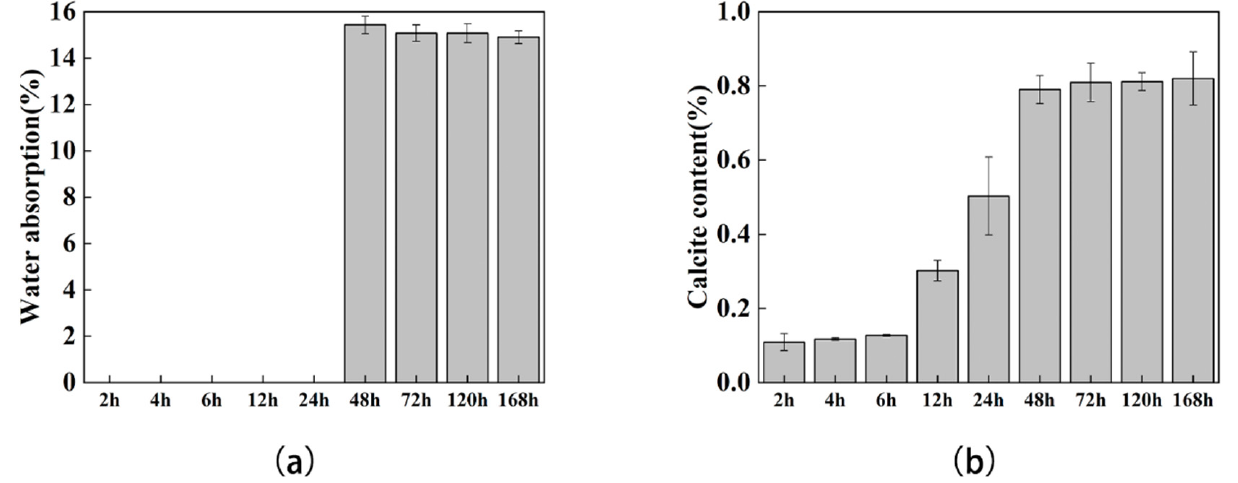
Figure 6. Water absorption and calcite mass test: ( a ) water absorption test results of specimens, ( b ) calcite content test results of specimens.